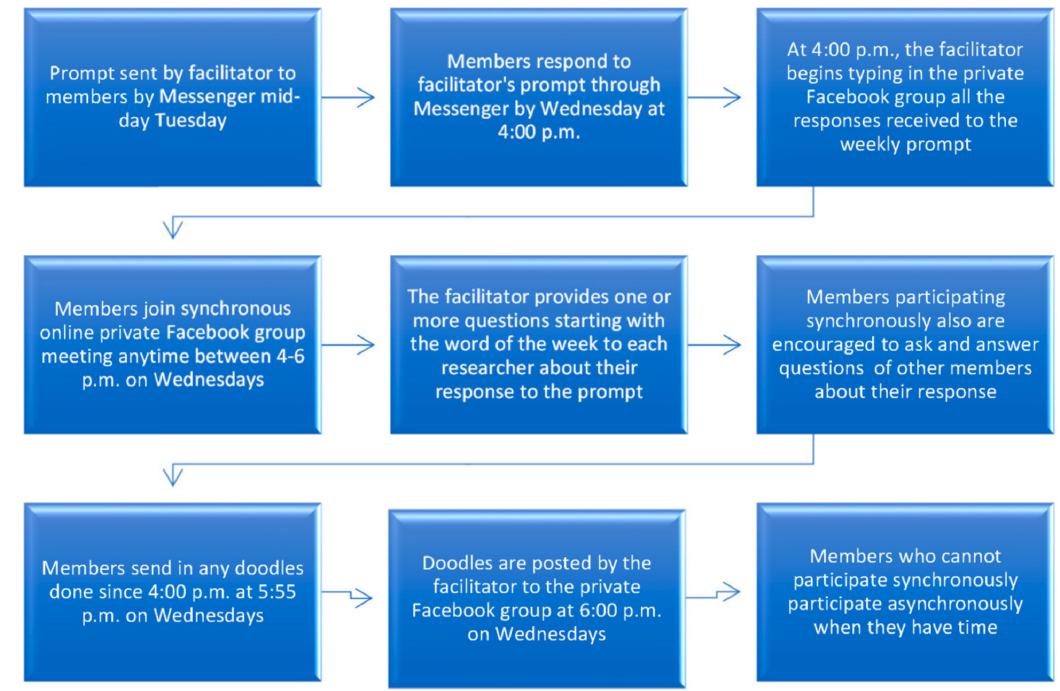
Figure 1. Weekly activities created and administered by the facilitator of the HeNReG for participants post-COVID-19 when group participation was entirely